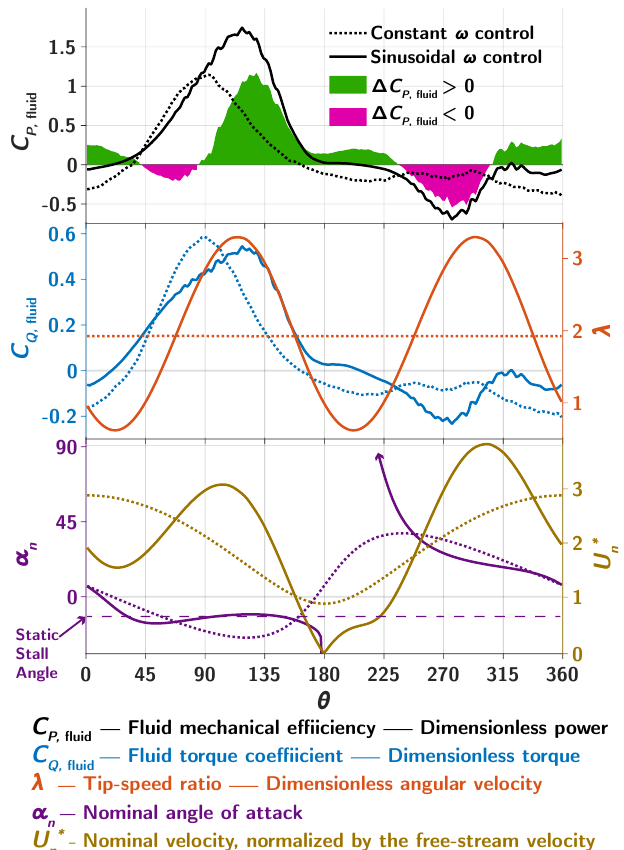
Fig. 5. Fluid power coefficient (top), fluid torque coefficient (center, blue), tip- speed ratio (center, red), nominal angle of attack (bottom, purple), and nominal freestream velocity (bottom, gold) for a one-bladed turbine under constant (dashed) and sinusoidal (solid) control are compared as functions of blade position. In the top plot, ∆ C P, fluid is difference in power coefficient between the sinusoidal and constant control schemes as a function of blade position. Green areas indicate greater power produced by the sinusoidal control scheme, while magenta indicates more power produced by the constant angular velocity control